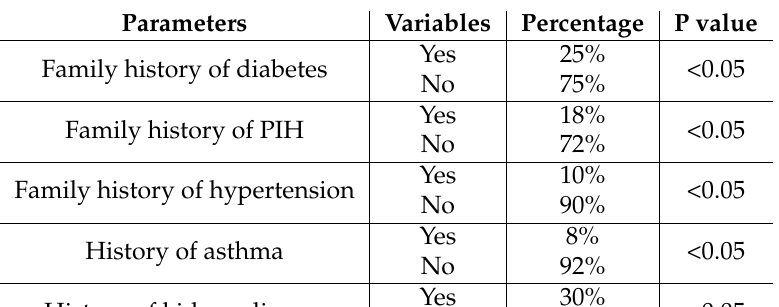
Table 2. Evaluation of risk